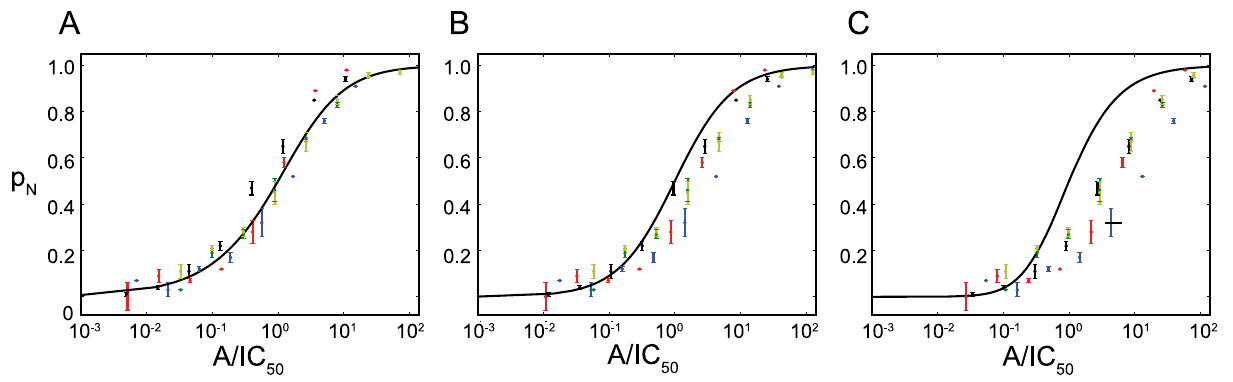
Figure 7. Fit of the model to the four neutralization experiments shown in Figure 5. A. A global nonlinear least squares fit was performed, fitting Eq. (18) to the four experiments with five free parameters, four IC 50 and s . The best fit values obtained were: s ~ 0 : 64 + 0 : 11 , and for the IC 50 values in m g/ml, 4E10 IgG= 4 : 3 + 1 : 6 , 4E10 Fab= 3 : 3 + 1 : 0 , 2F5 IgG= 0 : 68 + 0 : 18 , and 2F5 Fab= 4 : 5 + 1 : 5 . The neutralization data is plotted versus A = IC 50 using the determined IC 50 values. The solid curve is p cell , given by Eq. (18), with s ~ 0 : 64 and the best fit values for the four IC 50 . In B and C, s was fixed at s ~ 1 and s ~ 2 respectively and only the four IC 50 values were varied. The neutralization data is plotted versus A = IC 50 using the determined IC 50 values for the fixed values of s .